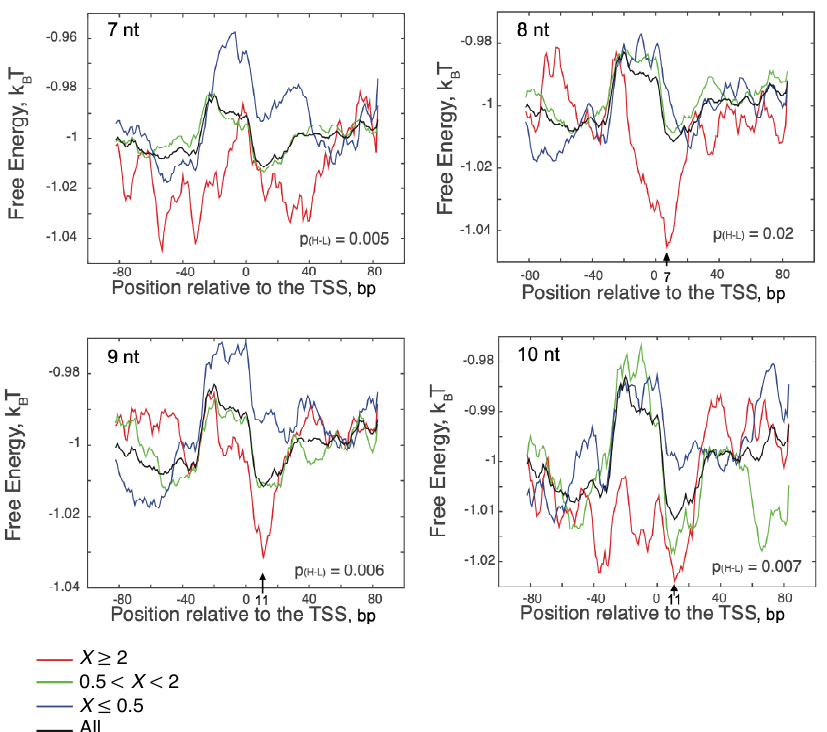
Figure 5. The free energy index for the nonconsensus mode of RNAP-DNA binding (FEINC) was reduced for the initiation complex in the vicinity of TSS. Here we grouped the sequences into three groups according to the ratio, X = nrt ( ∆ greAB ) / nrt (WT), for the RNET-seq reads with the length of 7 nt, 8 nt, 9 nt, and 10 nt, respectively, mapped to TSS of each σ 70 promoter. FEINC was calculated as described in Materials and Methods. In each plot for 8 nt, 9 nt, and 10 nt, a base position that has the lowest free energy is shown with an arrow. The computed P -values (H-L) evaluate the statistical significance of the di ff erence between the high ratio (X ≥ 2) and the low ratio (X ≤ 0.5) groups. The calculation of these P -values is described in Materials and